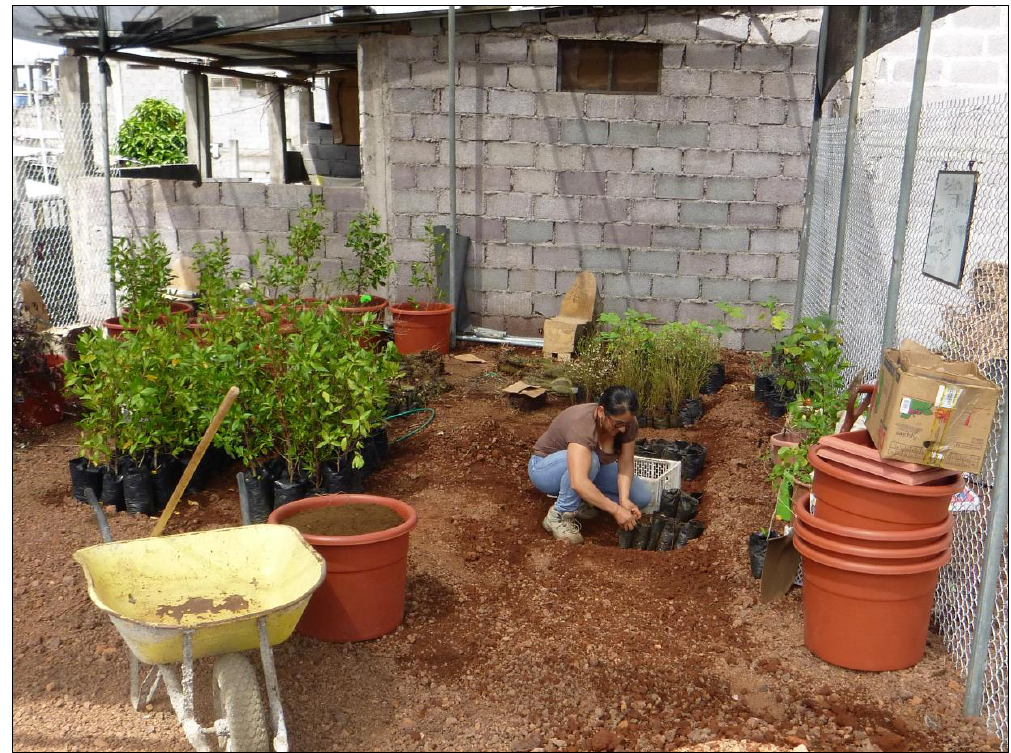
Figure 5. The shop. Photo by author.